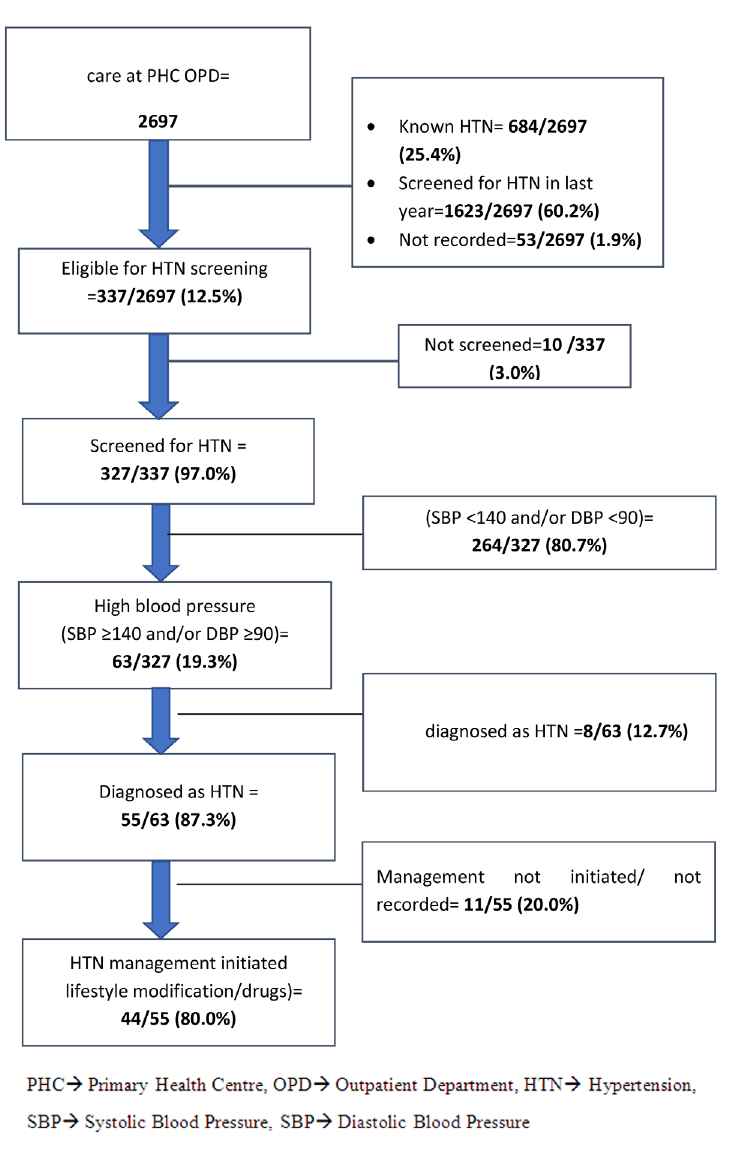
Figure 2. Flow diagram depicting the number eligible, screened, diagnosed and management for hypertension (HTN) among persons aged ≥ 30 years seeking health care in the two selected primary health centres (PHCs) from March to May